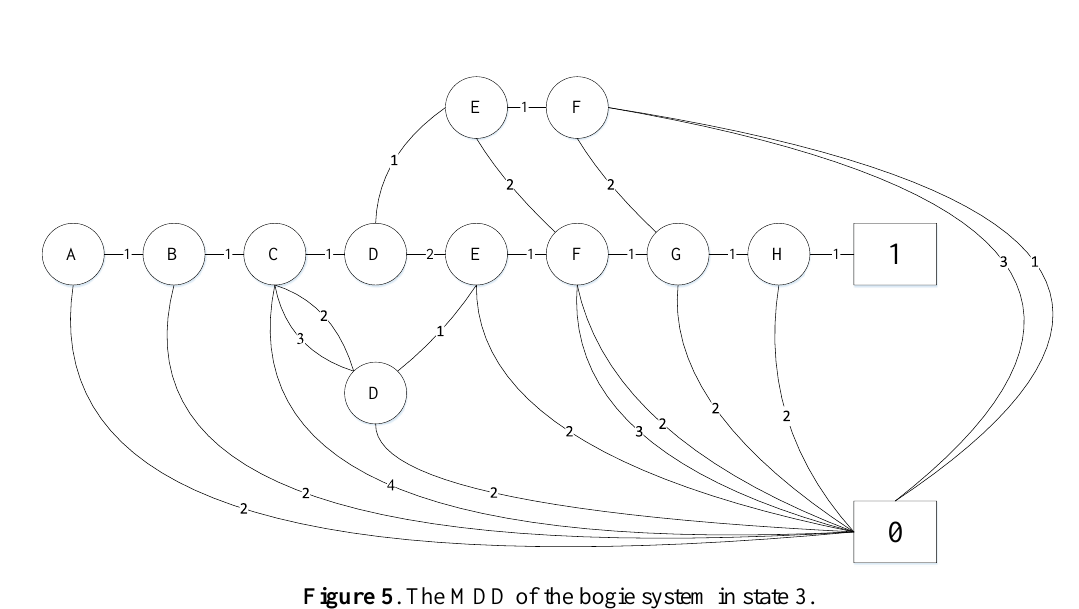
Figure 5 . The MDD of the bogie system in state 3.